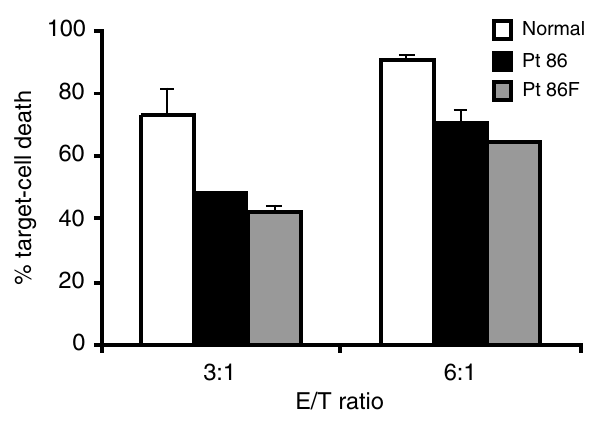
Figure 5 Cytotoxic effects of patient PBLs on Jurkat cells. The acti- vated PBLs from normal controls (open), Pt 86 (FasL R156G, black), and father of Pt 86 (shaded) were used as the effector cells to mix with Jurkat (target) cells at the E/T ratios shown. Means and error bars of % target cell death are shown, data represent two independent